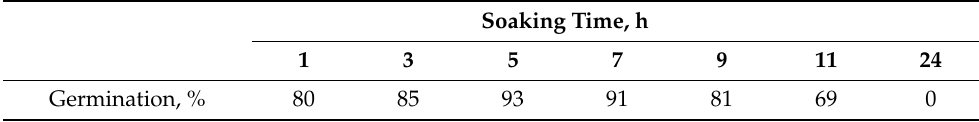
Table 3. Germination of sorghum seeds after short-term soaking in activated water.